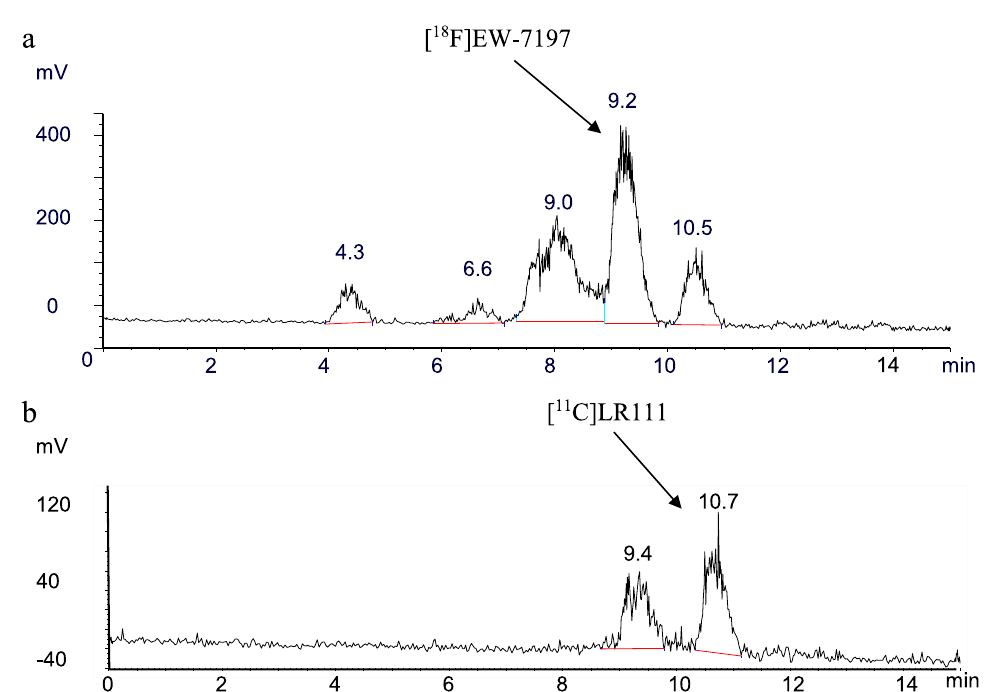
Fig. 6 Radio-HPLC chromatograms of the non-polar metabolite fractions in rat plasma for a [ 18 F]EW-7197 ( R t non-polar metabolites ( R t 4.3, 6.6, 9.0 and 10.5 min). b [ 11 C]LR111 ( R t =